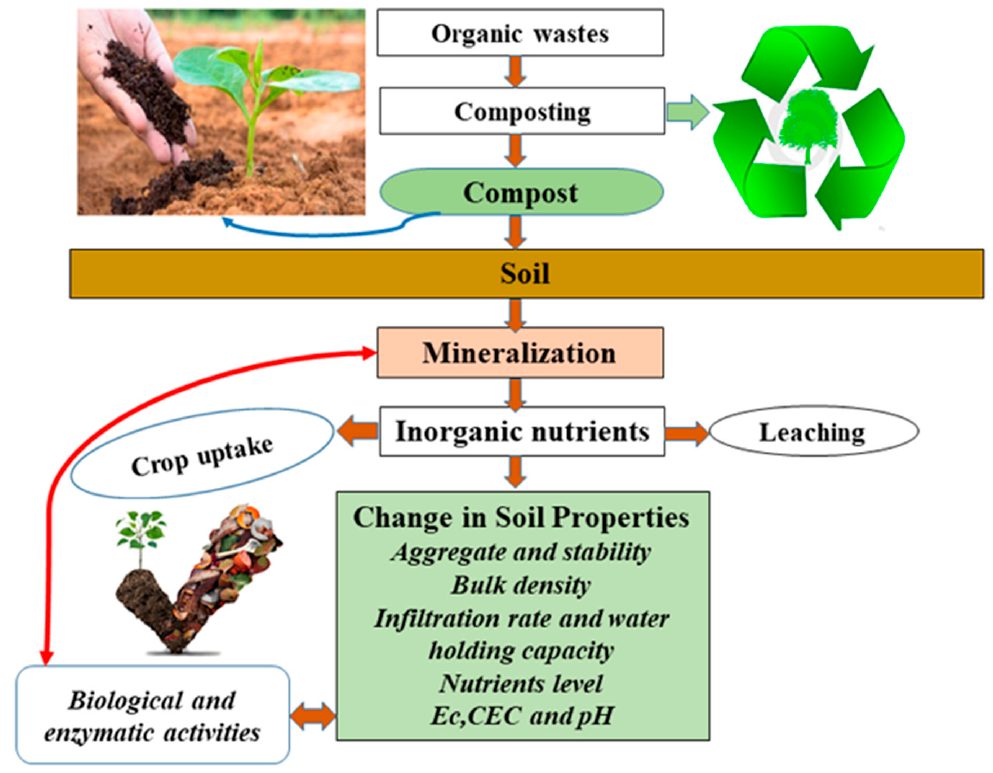
Figure 1. Schematic diagram of compost mineralization after application to soil. EC: Electrical conductivity, CEC: Cation exchange capacity.